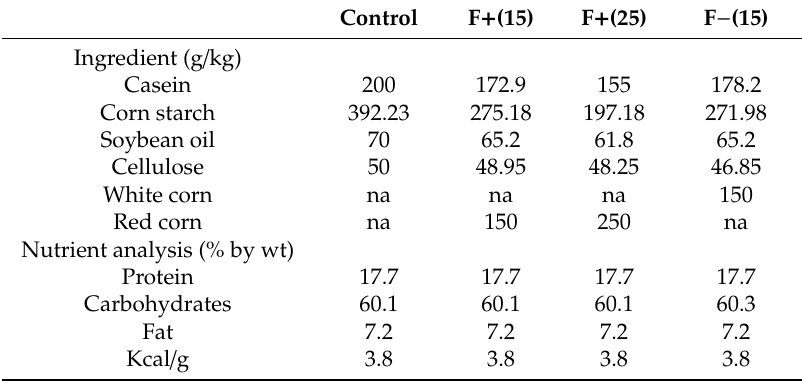
Table 2. Composition of experimental mice